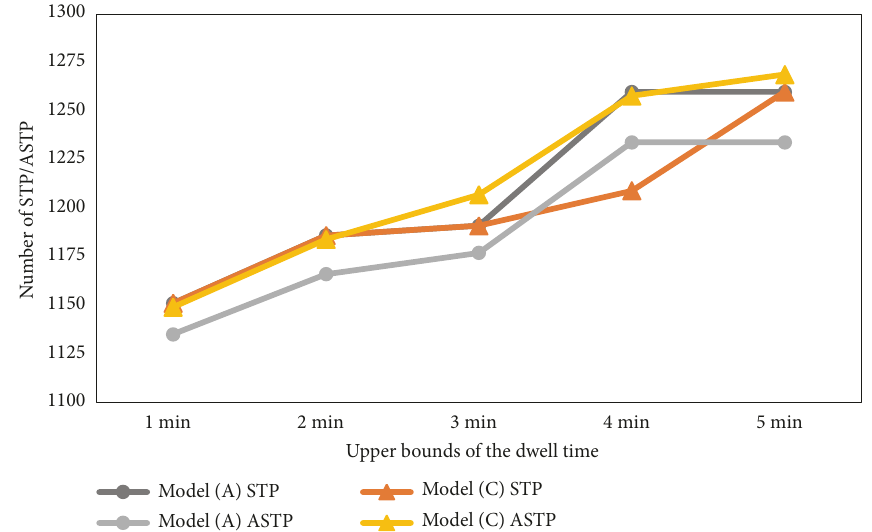
Figure 6: Effect of the dwell time on transfer